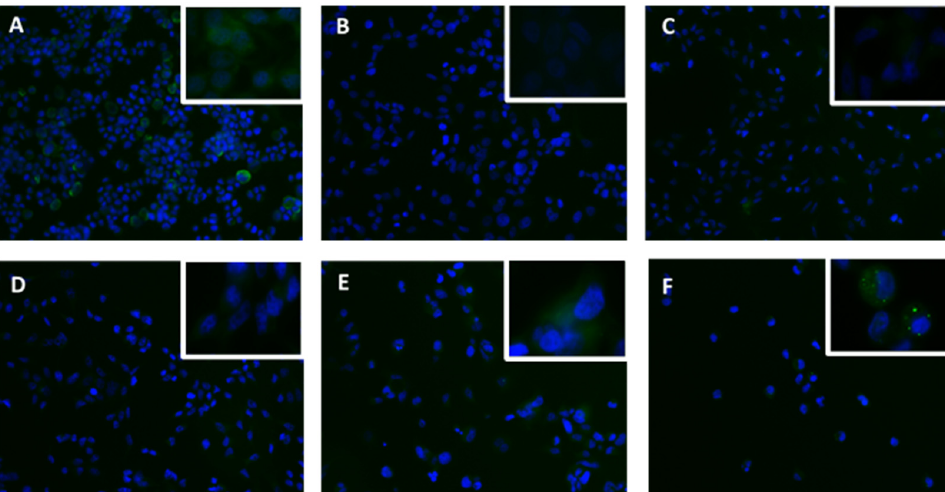
Figure 20. Immunofluorescence analysis of vimentin (green) in MCF-7 cells. ( A ) MCF-7 with no treatment; ( B ) Cells treated with the reference drug, paclitaxel; ( C ) Cells treated with benztropine; ( D ) Cells treated with thioridazine; ( E ) Cells treated with the combination of the IC50 of paclitaxel and benztropine; ( F ) Cells treated with the combination of the IC50 of paclitaxel and thioridazine. The cells were treated with the calculated IC50 concentration and were exposed to the drugs for 48 h. The images were taken at a 20 × magnification. On the right top corner of each image is an insert at 40 × magnification (20 × 30 ms DAPai/ 2s FITC; 40 × 4 ms DAPI/ 1 s FITC).